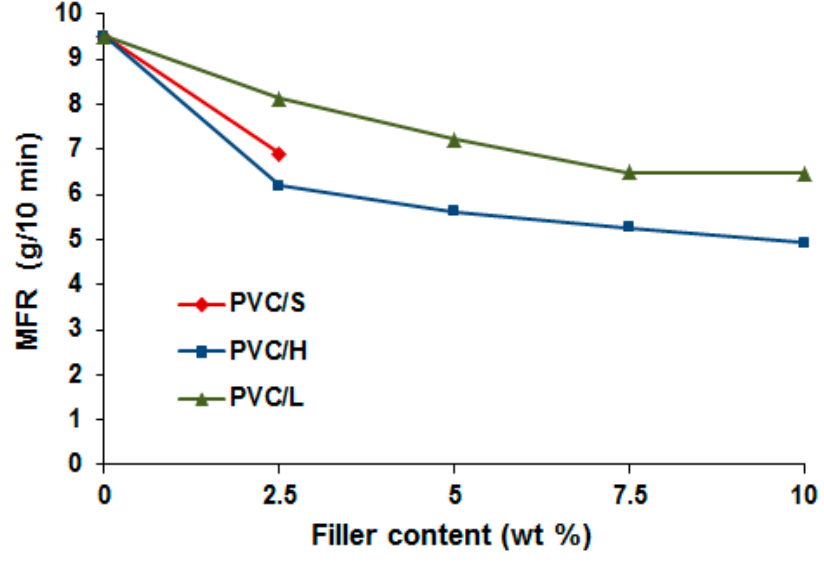
Figure 4. MFR of PVC and PVC composites vs. filler content.